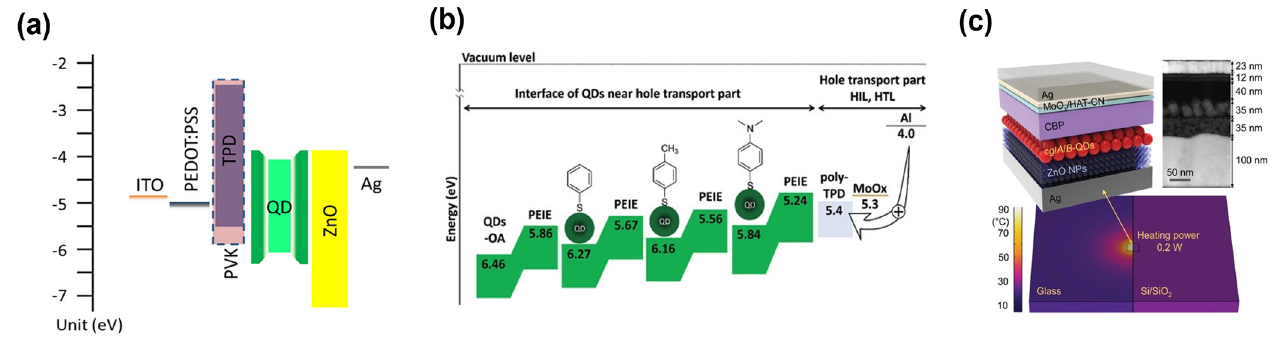
Figure 4. Device engineering methods: ( a ) Composite of PVK and TPD as the HTL for the QLED (Reproduced from [105] with permission from American Chemical Society). ( b ) Energy band diagram of the green QLED with interface-modified QDs (Reproduced from [122] with permission from Wiley). ( c ) Schematic illustration of an inverted top-emission QLED fabricated on substrates with a different heat dissipation property (Reproduced from [123] with permission from Wiley).